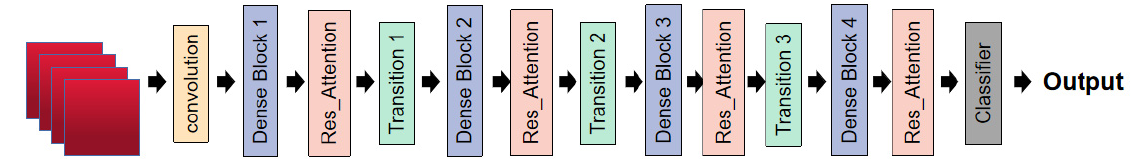
Figure 8. Structure of RiceDRA-Net network model for rice leaf disease identification.